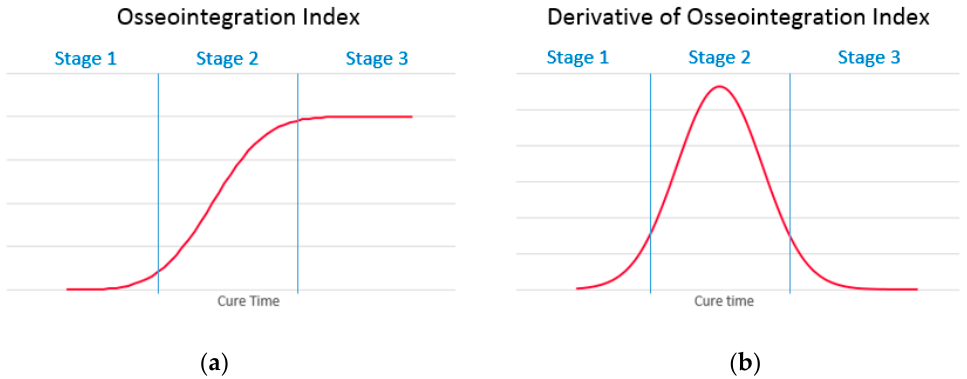
Figure 3. ( a ) Osseointegration Index and ( b ) its time derivative of an ideal model.